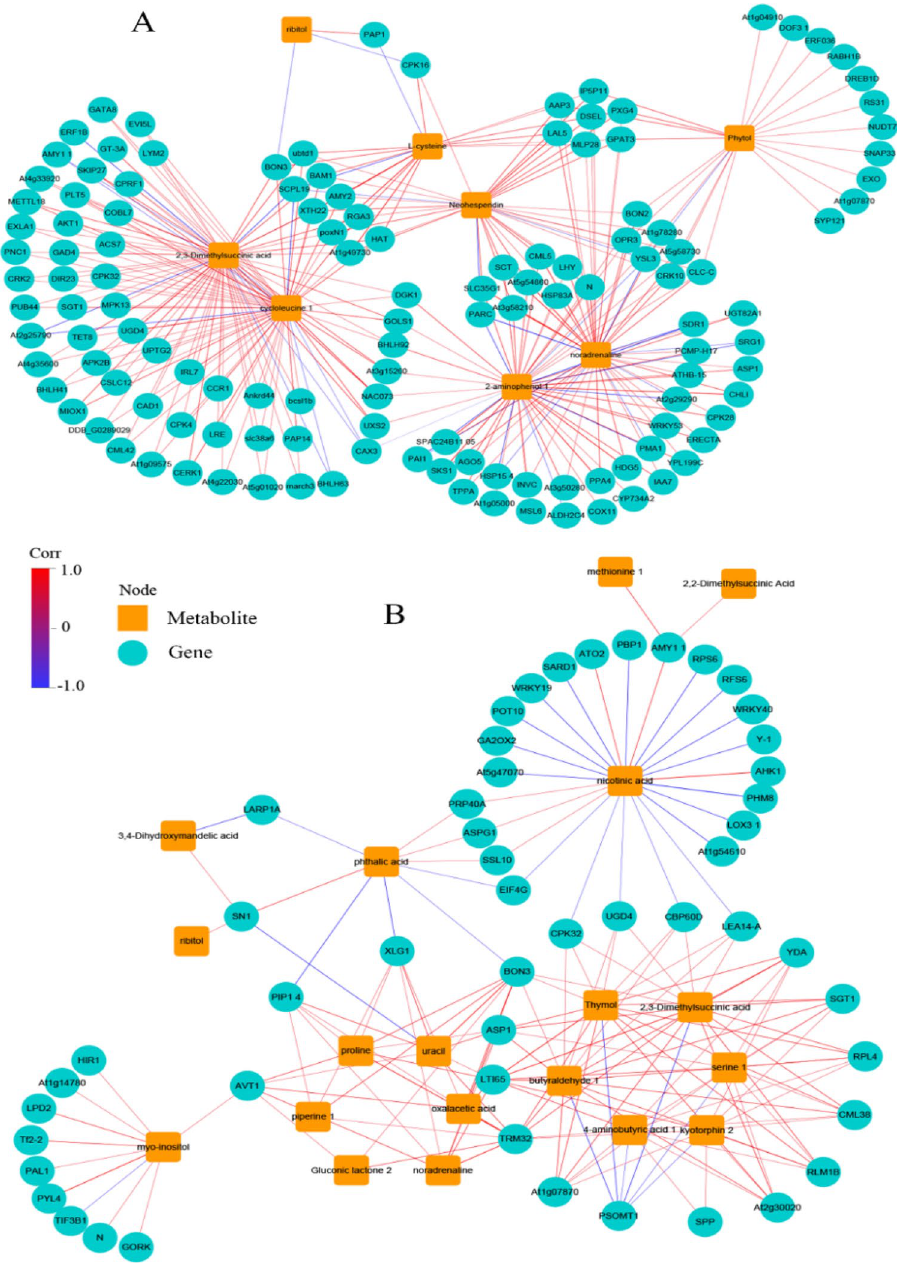
Figure 10. Differential genes-to-differential metabolites network in N. sibirica leaves. ( A ) T100L vs T0L; ( B ) T400L vs T0L. Orange squares represent differential metabolites, blue circles represent differential genes; connection colors represent correlations between nodes and nodes, red lines indicate positive correlations, and blue lines indicate negative